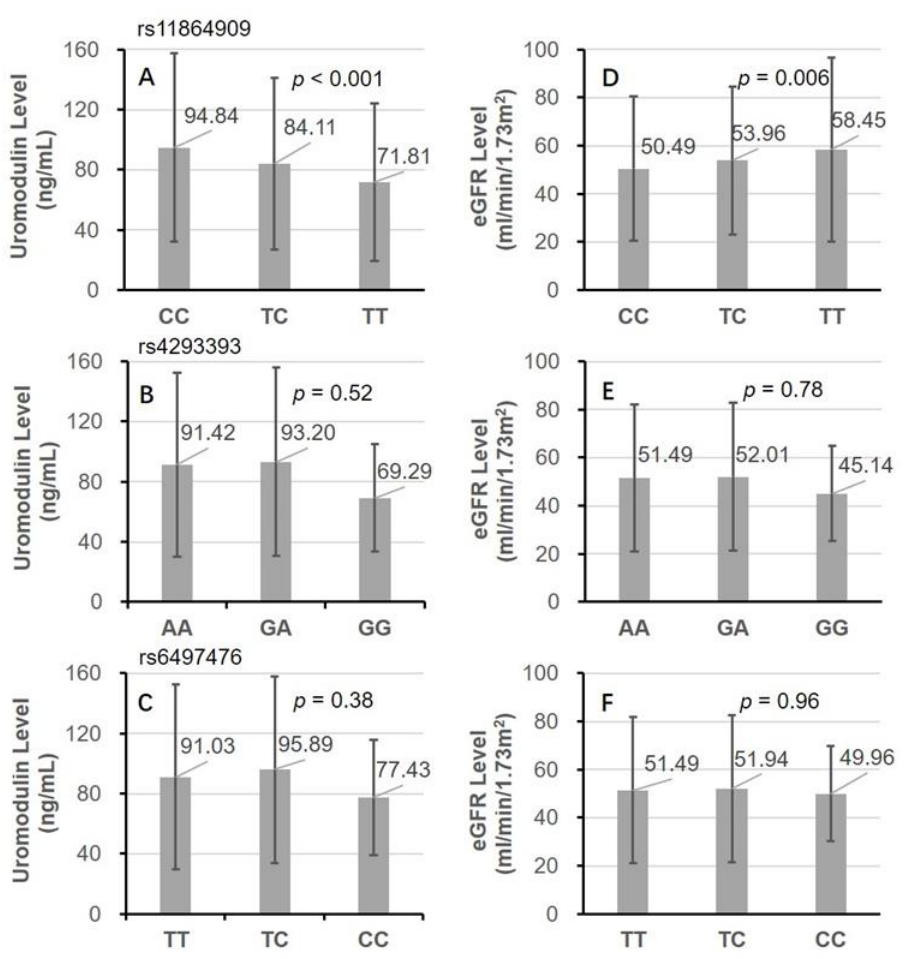
Figure 2. The distribution of serum uromodulin and eGFR between genotypes of rs11864909, rs4293393, and rs6497476. ( A ) Uromodulin levels through genotypes of rs11864909; ( B ) uromodulin levels through genotypes of rs4293393; ( C ) uromodulin levels through genotypes of rs64974763; ( D ) eGFR levels through genotypes of rs11864909; ( E ) eGFR levels through genotypes of rs4293393; ( F ) eGFR levels through genotypes of rs64974763.